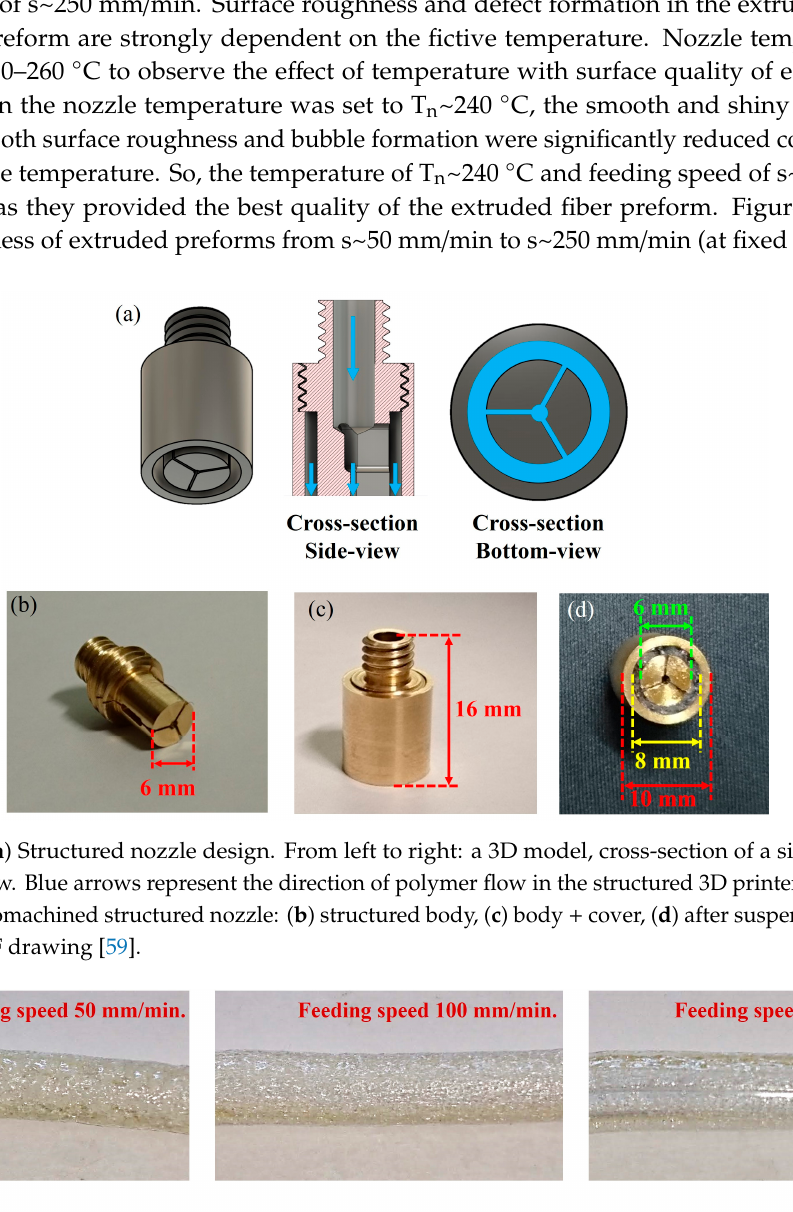
Figure 8. Extruded fiber preform from the 3D printer with different filament feeding speeds at T n = 240 °C.